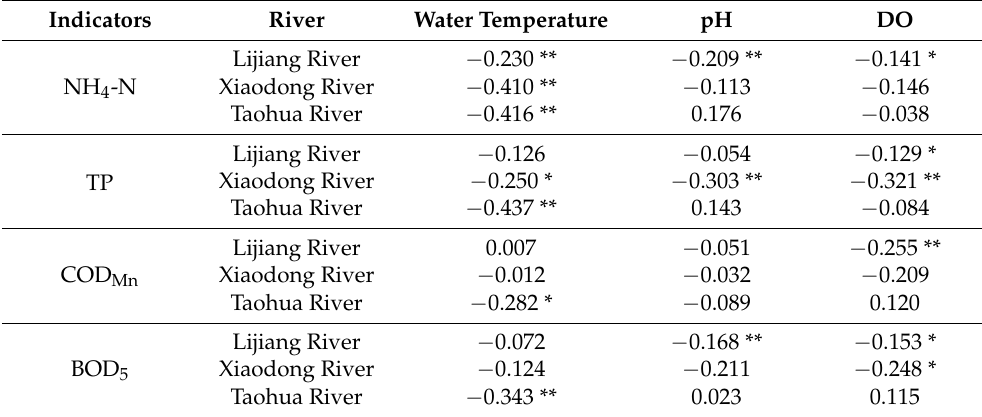
Table 2. Spearman correlation coefficient of different river environmental factors and water qual- ity indicators. Indicators River Water Temperature pH DO NH 4